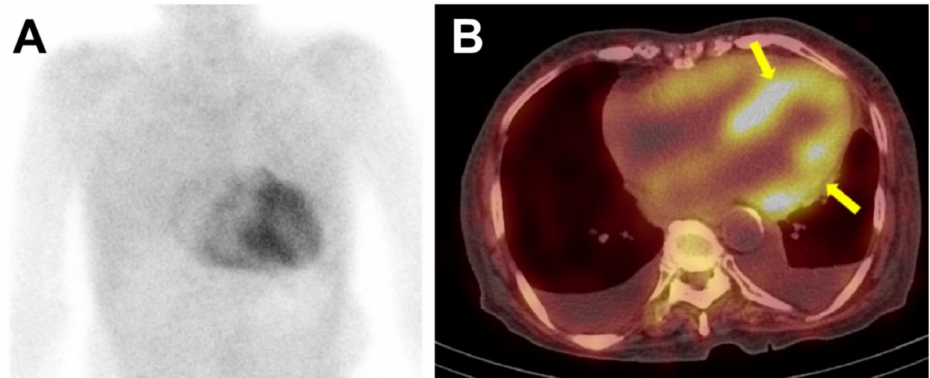
Figure 4. The 99m Tc-DPD bone scintigraphy and single-photon emission computed tomography (SPECT) of a patient with ATTR-cardiac amyloidosis. In Figure 4, the anterior planar image (panel A ) showed intense, heterogeneous cardiac uptake greater than rib uptake in intensity, considered as Perugini grade 3. No abnormal radiotracer uptake was seen in other organs such as the liver or kidney. SPECT images (panel B ) were acquired immediately after the planar imaging, and the radiotracer uptake could be localized to the myocardium (arrows), and not in the blood pool. Bilateral pleural effusion was also